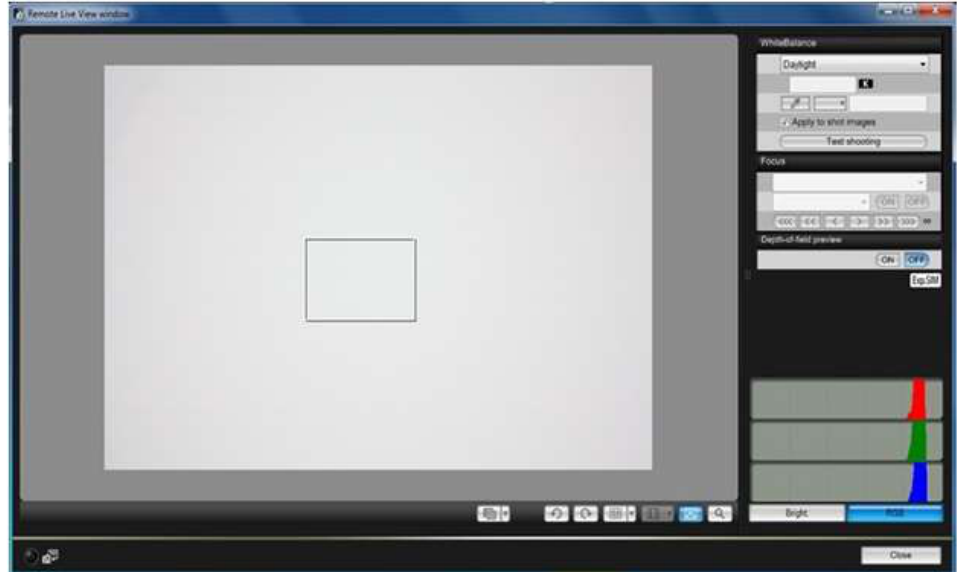
Figure 4. Light-calibration protocol.